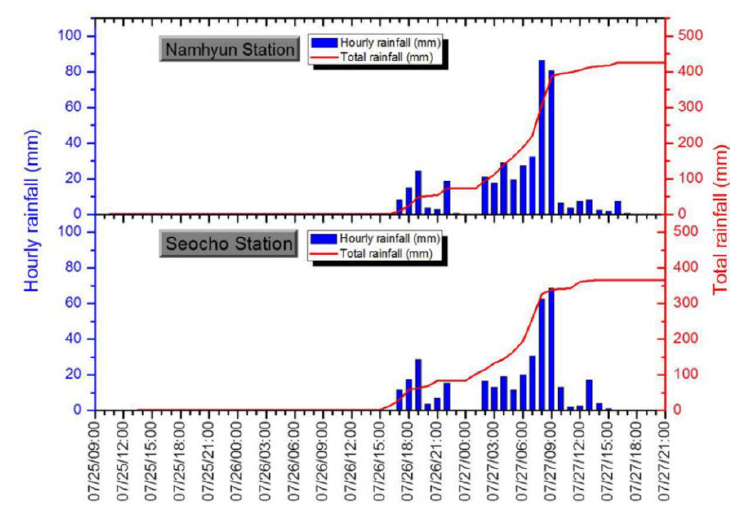
Figure 2. Hourly and total rainfall distribution on 25–27 July 2011 at Namhyun and Seocho rainfall station [29].